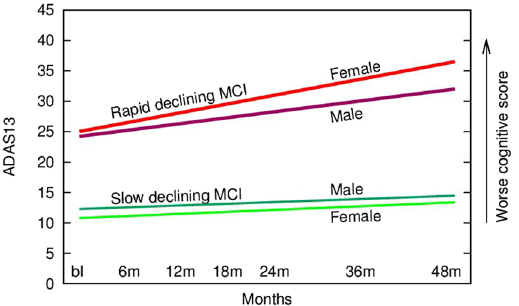
Figure 4. X-axis depicts duration of follow up. Y-axis depicts ADAS-Cog-13 total scores and higher scores depict greater worsening of cognition (due to more cognitive errors). The slopes depict sex-specific cognitive baseline and endpoint scores for slow versus rapid declining subpopulations of MCI